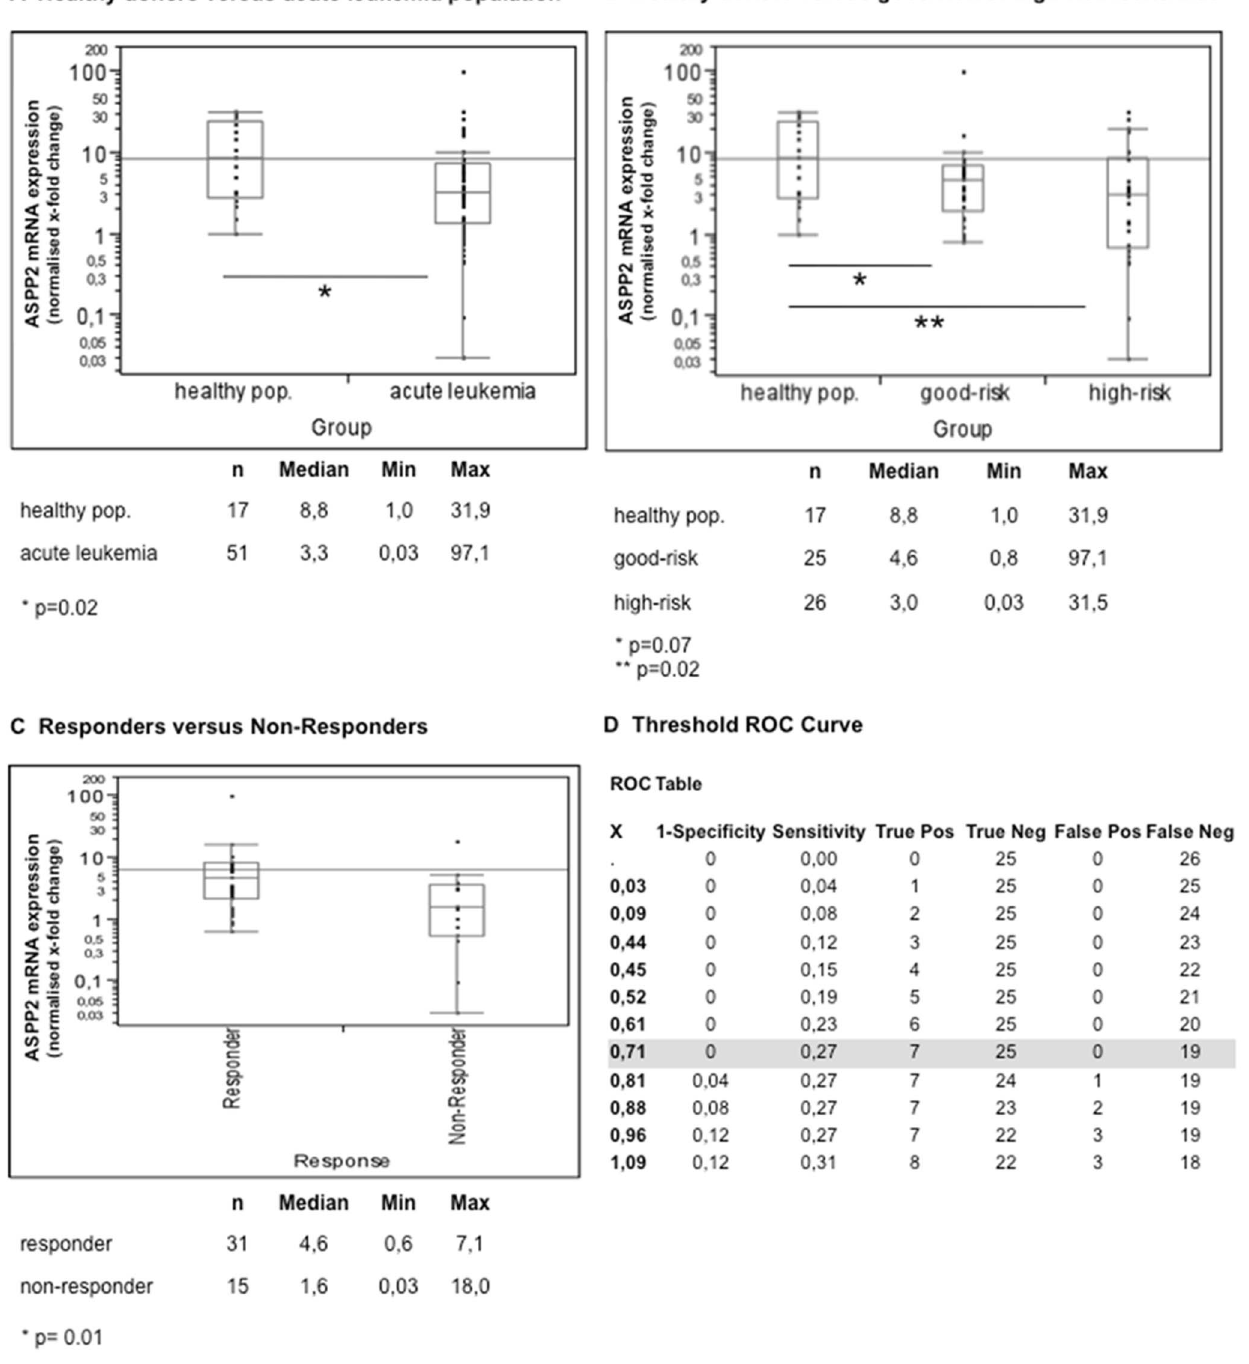
Figure 1. ASPP2 mRNA expression in acute leukemia. qRT-PCR based mRNA expression levels are displayed after normalizing to a healthy blood donor (set as 1) on a logarithmic scale. Cohort analysis reveals significant lower ASPP2 levels for an acute leukemia population compared to a healthy peripheral blood and bone marrow donor cohort (A). Comparison of prognostic risk groups confirms lower ASPP2 expression levels for the good-risk as well as higher-risk cohort when compared to a healthy donor population – whereas attenuated ASPP2 expression levels are more pronounced and statistically significantly different for the higher-risk cohort (B). Analysis of therapy responders (i.e. achievement of complete remission after one cycle of induction chemotherapy) demonstrates significantly lower ASPP2 levels for the therapy-failure population when compared to the responder cohort (including good-/higher-risk pts.) (C). ROC curve analysis defining the ideal threshold to distinguish a definite non- responding sub-population is shown in figure 1D (i.e. patients with attenuated ASPP2 expression levels # 0.8 are likely not to respond to induction chemotherapy (with no single falsely positive tested patient at this threshold). P-values are provided as indicated by an asterix. Patient characteristics, including definitions of the prognostic risk groups, are summarized in Table 1 and 2.